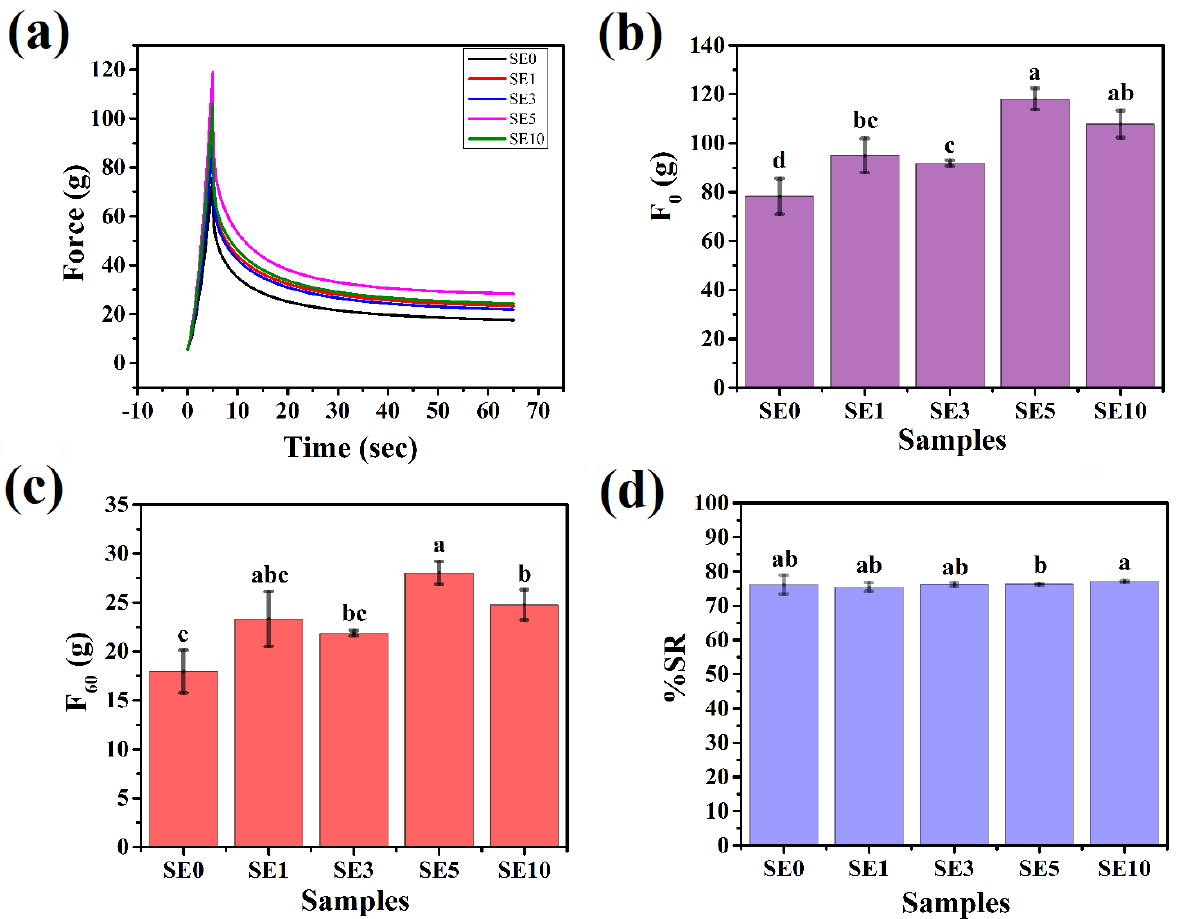
Figure 6. Mechanical parameters: ( a ) Stress relaxation profile, ( b ) F 0 values, ( c ) F 60 values, and ( d ) %SR values. The values denoted in the graph are the average ± SD of triplicate samples (Significance level, p = 0.05). Bars with different letters differ significantly ( p < 0.05).